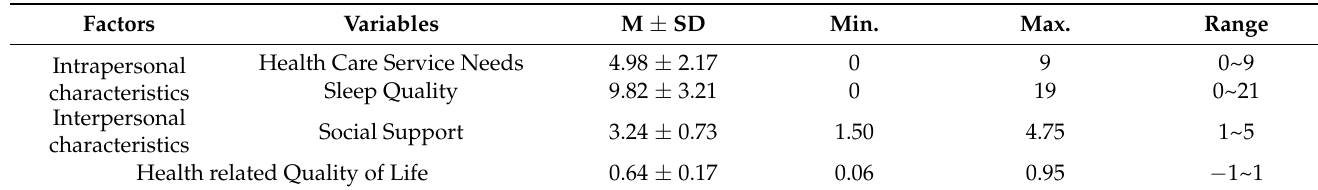
Table 2. Scores between Health Care Service Needs, Sleep Quality, Social Support, and Health-Related Quality of Life of the Participants ( N =